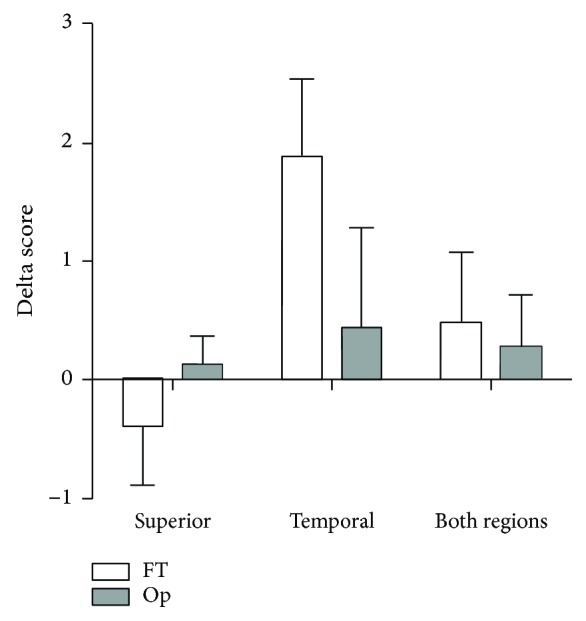
Mean and SEM of impression cytology score deltas calculated by the difference between 3 months (T3) values and before surgery (T0) values. No difference was found between FT and Op treatments (Mann-Whitney, p > 0.05).